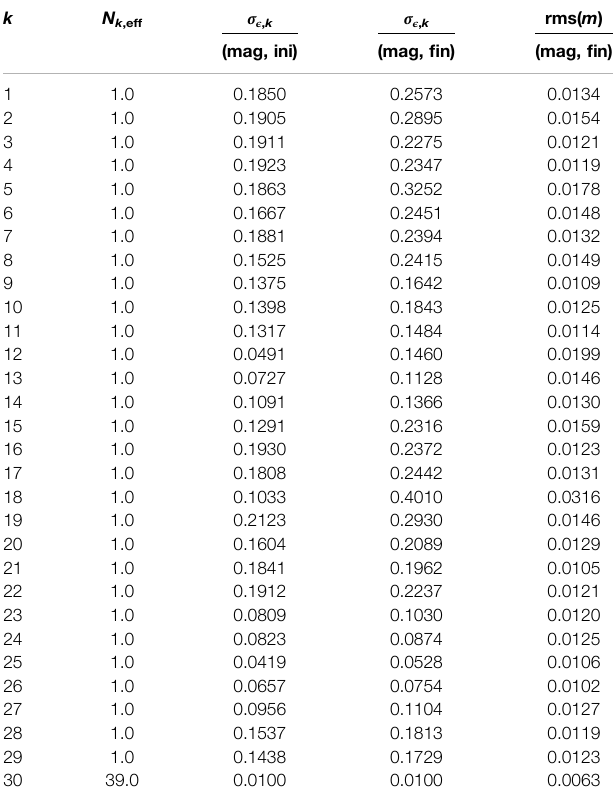
TABLE 7 | As in Table 6 for the GS-asteroid in the case of absolute photometry with N k ,eff = 1 in Eq. 23